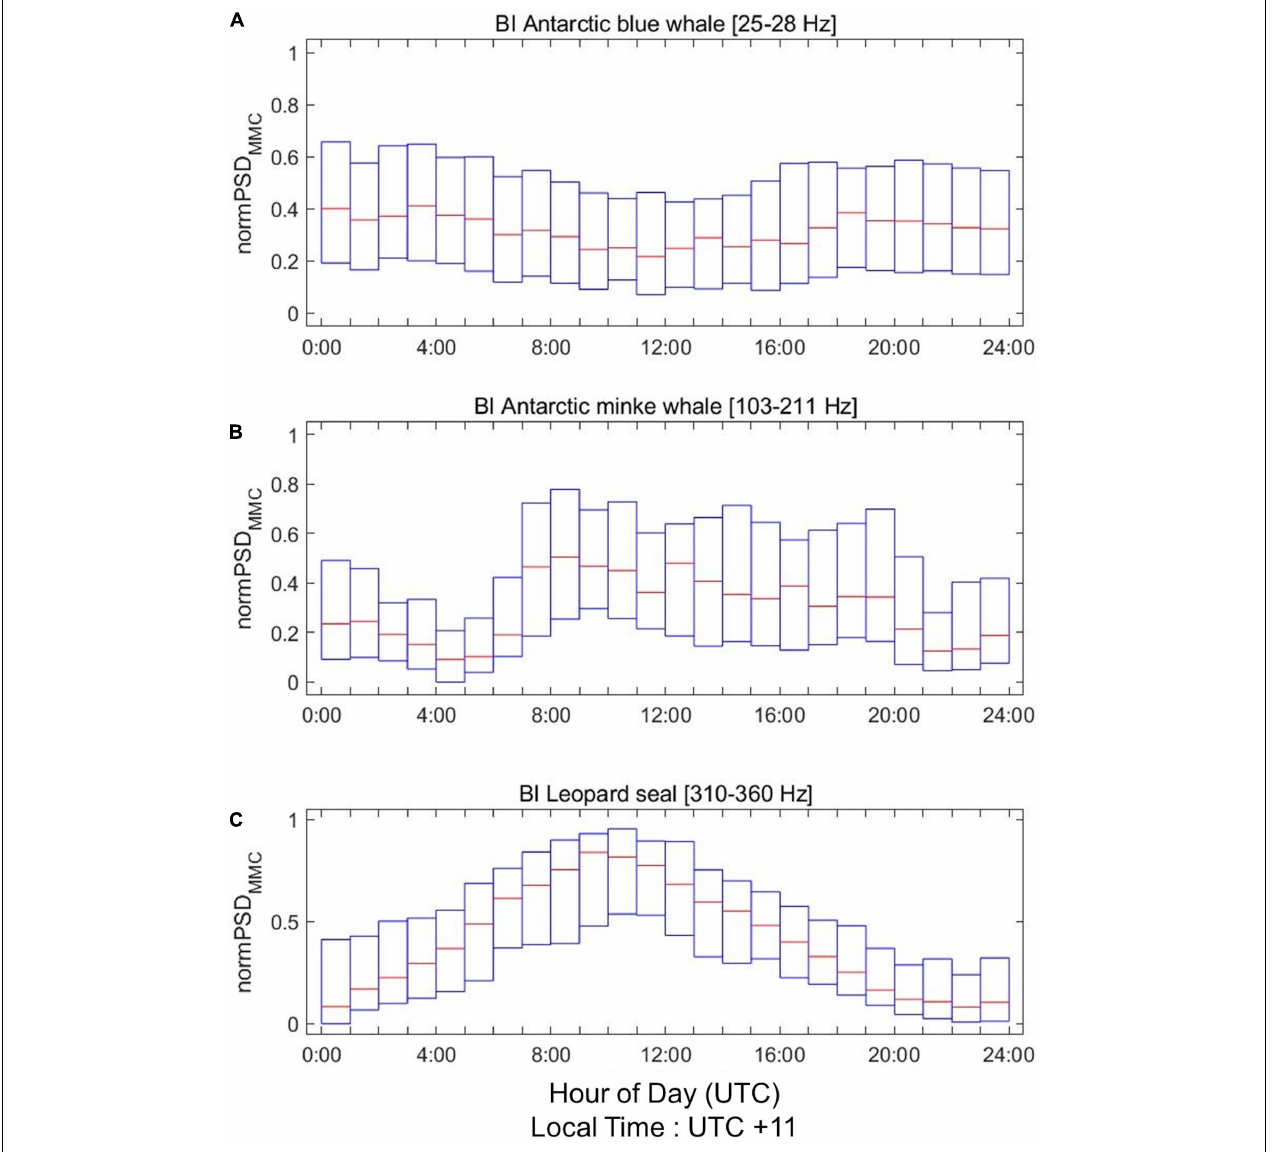
FIGURE 6 | Diel patterns in normalized PSD MMC values of (A) Antarctic blue whales, (B) Antarctic minke whales (middle), and (C) leopard seals (bottom) in the BI region. X axis represents the UTC time, and the local time in the BI region is UTC + 11. Estimated hourly PSD MMC values are normalized between 0 and 1 for each day. Red line indicates the median value, and the bottom and top edges of the box indicate the 25th and 75th percentiles,